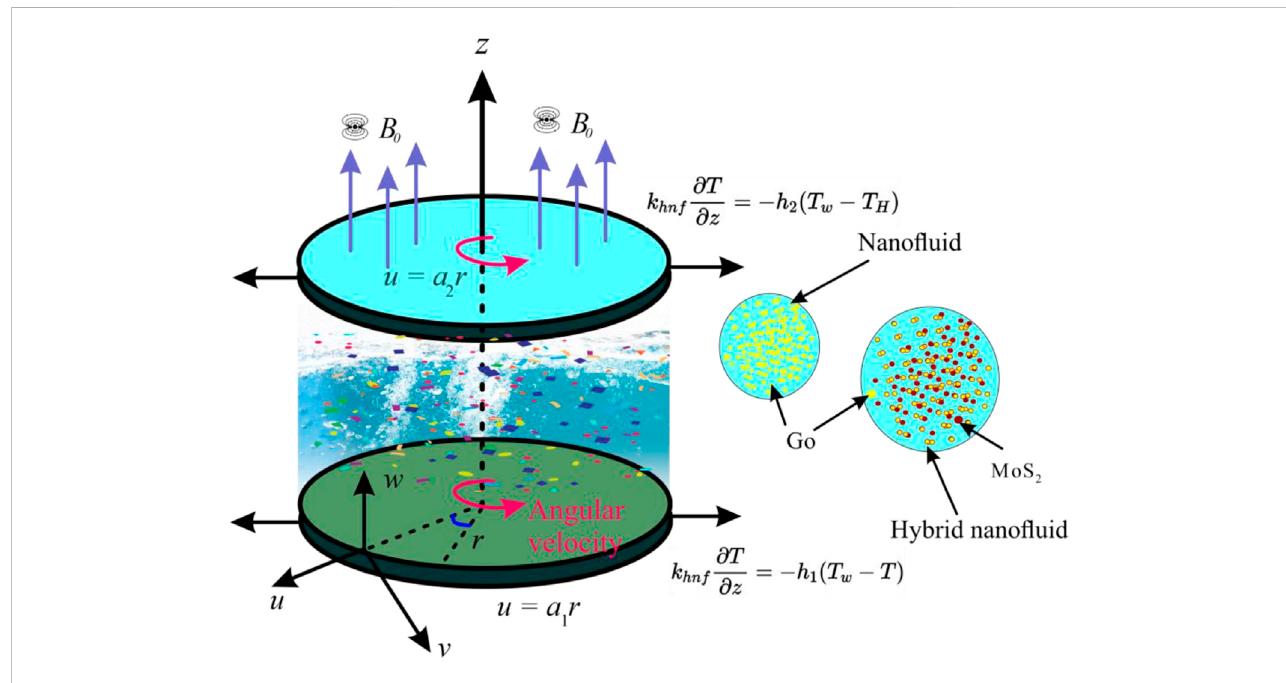
FIGURE 1 Physical